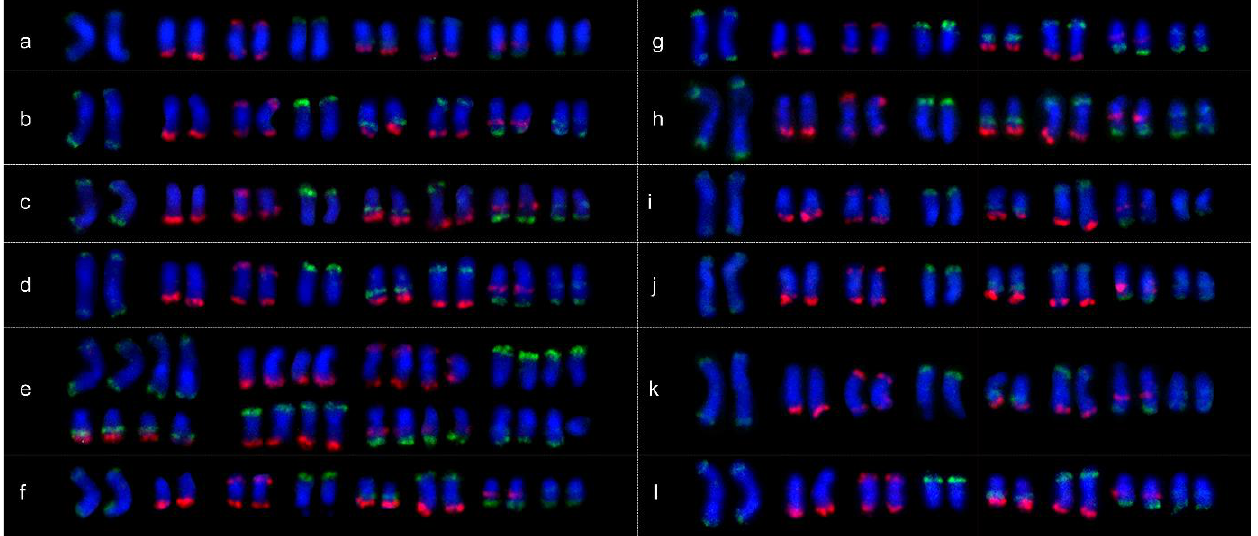
Figure 5. Chromosome identification in metaphase spreads of species closely related to Chinese cherry. ( a ) P. avium _Mazzard, ( b ) P. avium _Van, ( c ) P. yedoensis _DJYH, ( d ) P. campanulata _ZHYT, ( e ) P. cerasus _SYT, ( f ) P. humilis _Ouli, ( g ) P. tomentosa _red_fruit, ( h ) P. tomentosa _white_fruit, ( i ) P. salicina _SYL, ( j ) P. armeniaca _DGX, ( k ) P. dulcis _BT, and ( l ) P. persica _MT.